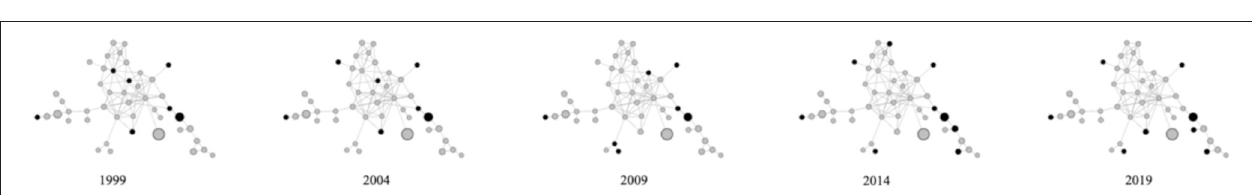
FIGURE 6 | Evolution of medical device product space in